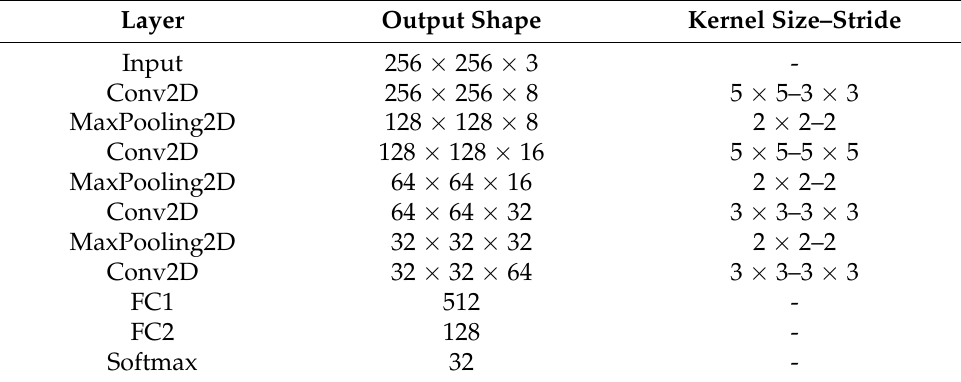
Figure 5. Architecture of the proposed classifier model. Table 4. Configuration of the proposed classifier